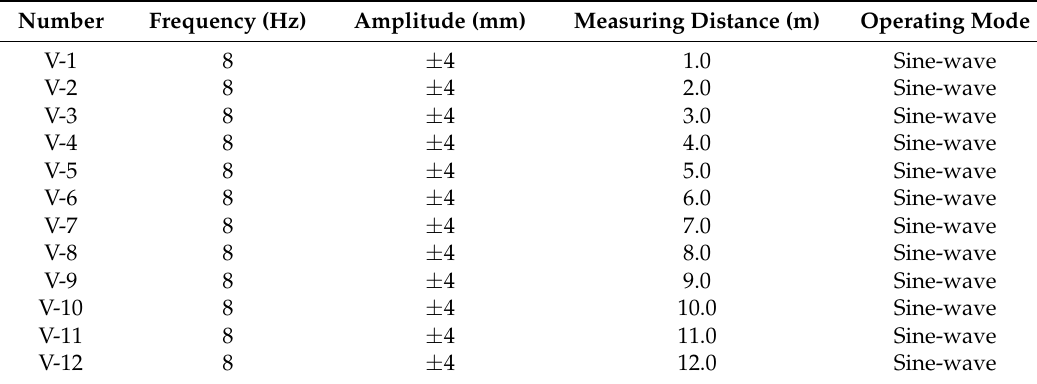
Table 14. Experimental parameters of measuring distance